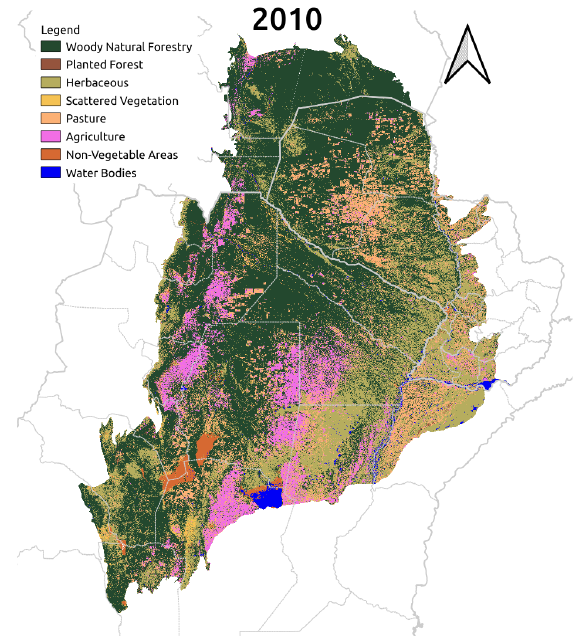
Figure 2. Map of the Gran Chaco for the initial years 2010 of the period evaluated by this study.